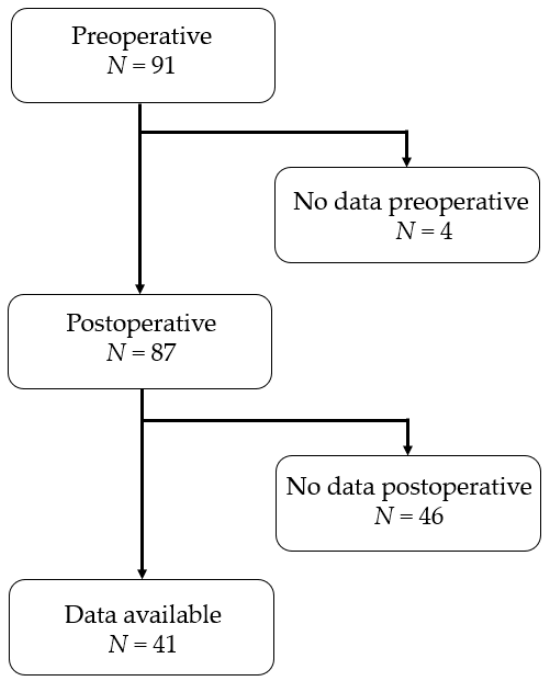
Figure 1. Flowchart of the study.